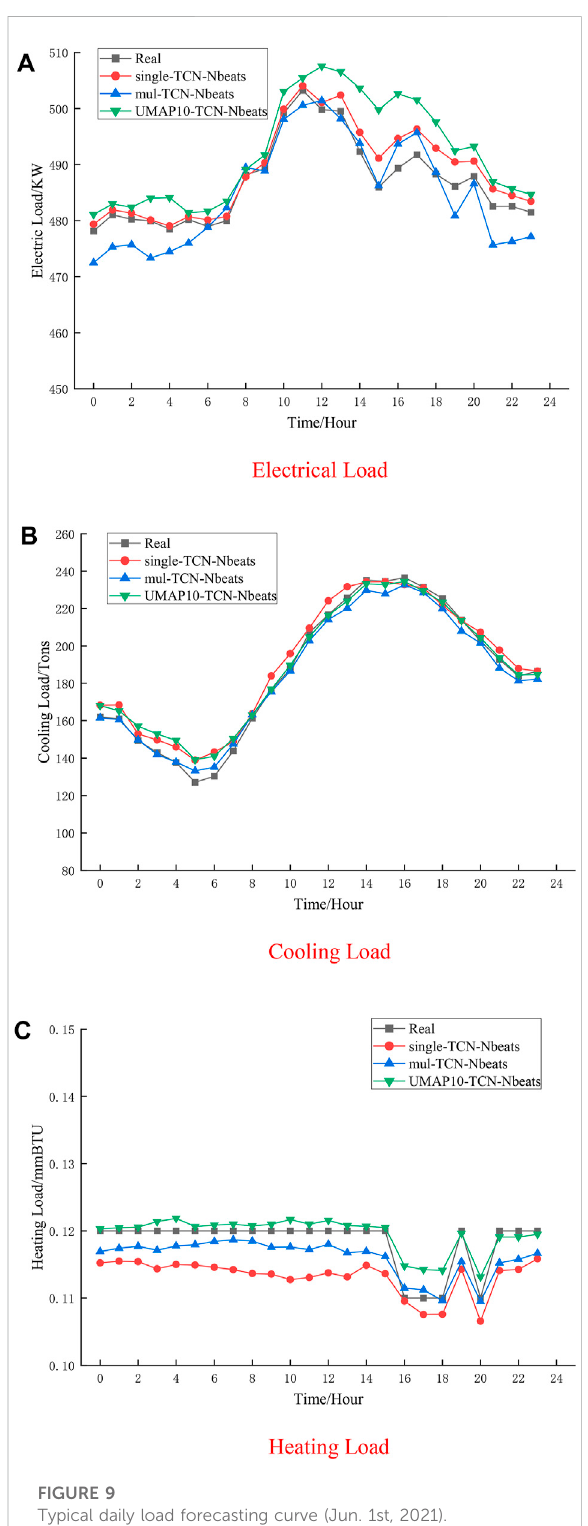
FIGURE 9 Typical daily load forecasting curve (Jun. 1st,